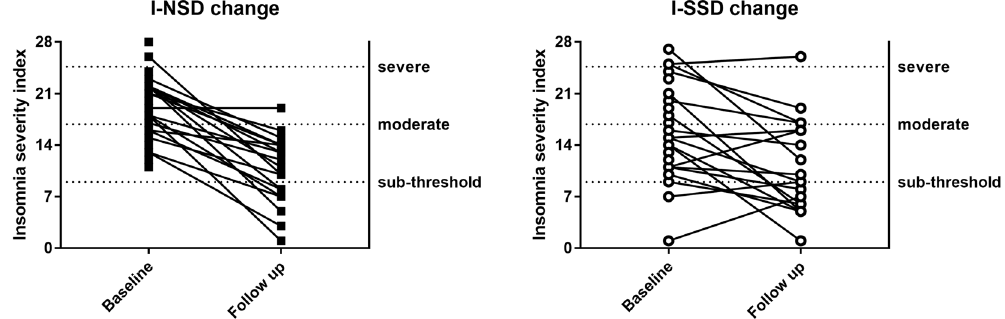
Figure 2. Insomnia severity index scores for all participants by subtype who underwent overnight polysomnography linked before and after three months cognitive behavioural therapy. I-NSD: Insomnia with normal sleep duration; I-SSD: Insomnia with short sleep